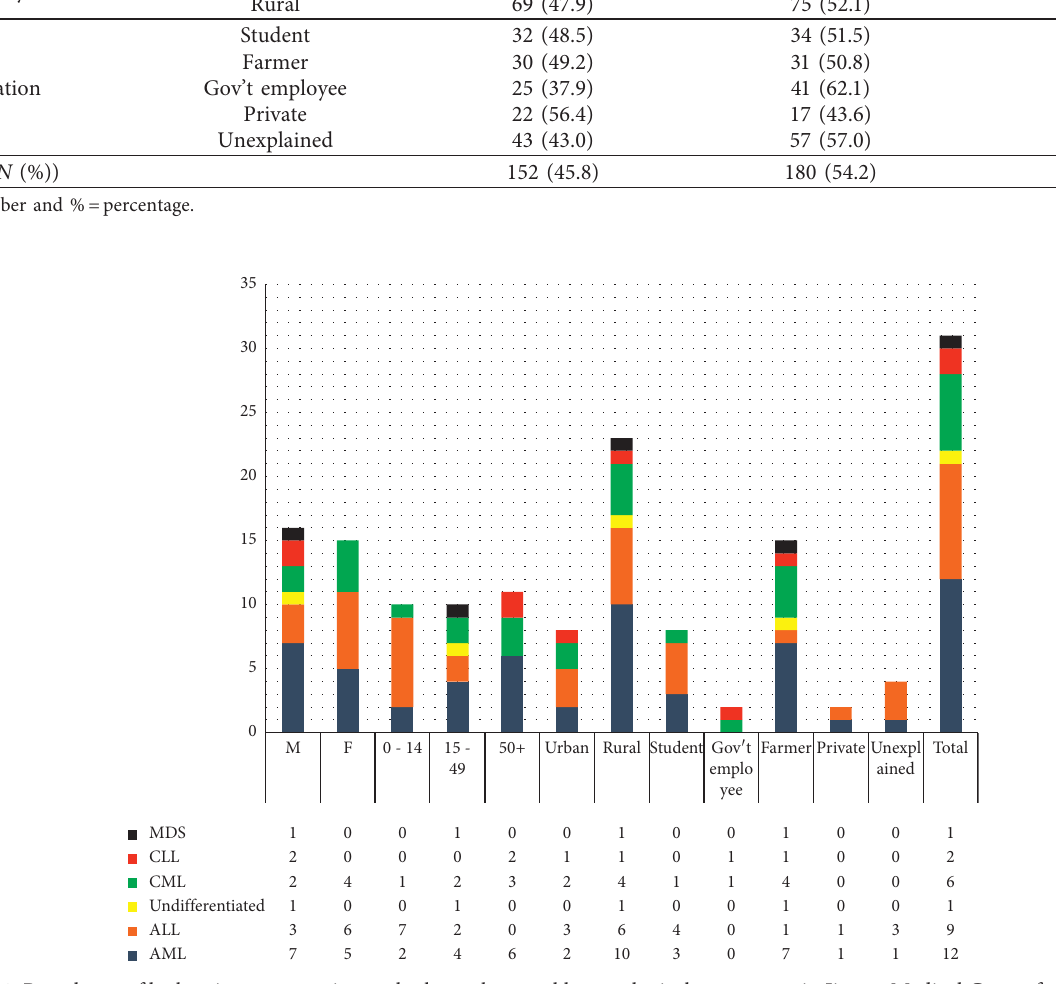
Figure 1: Prevalence of leukemia among patients who have abnormal hematological parameters in Jimma Medical Center from January 1, 2019, to April 30, 2019.